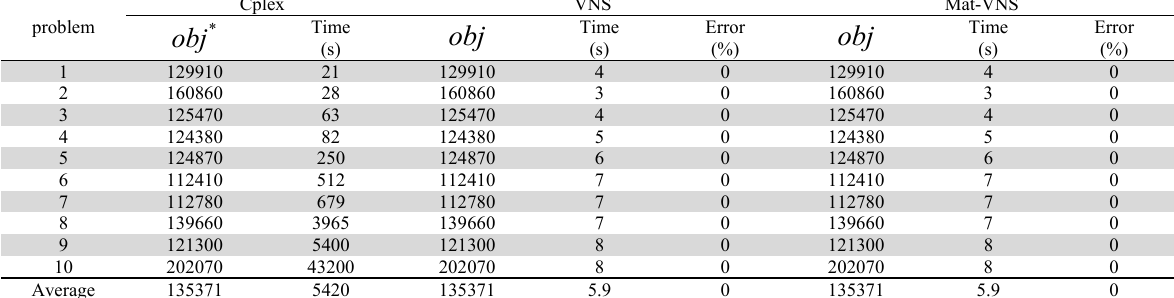
The obtained results from VNS and Mat-VNS algorithms and Cplex for small scale problems